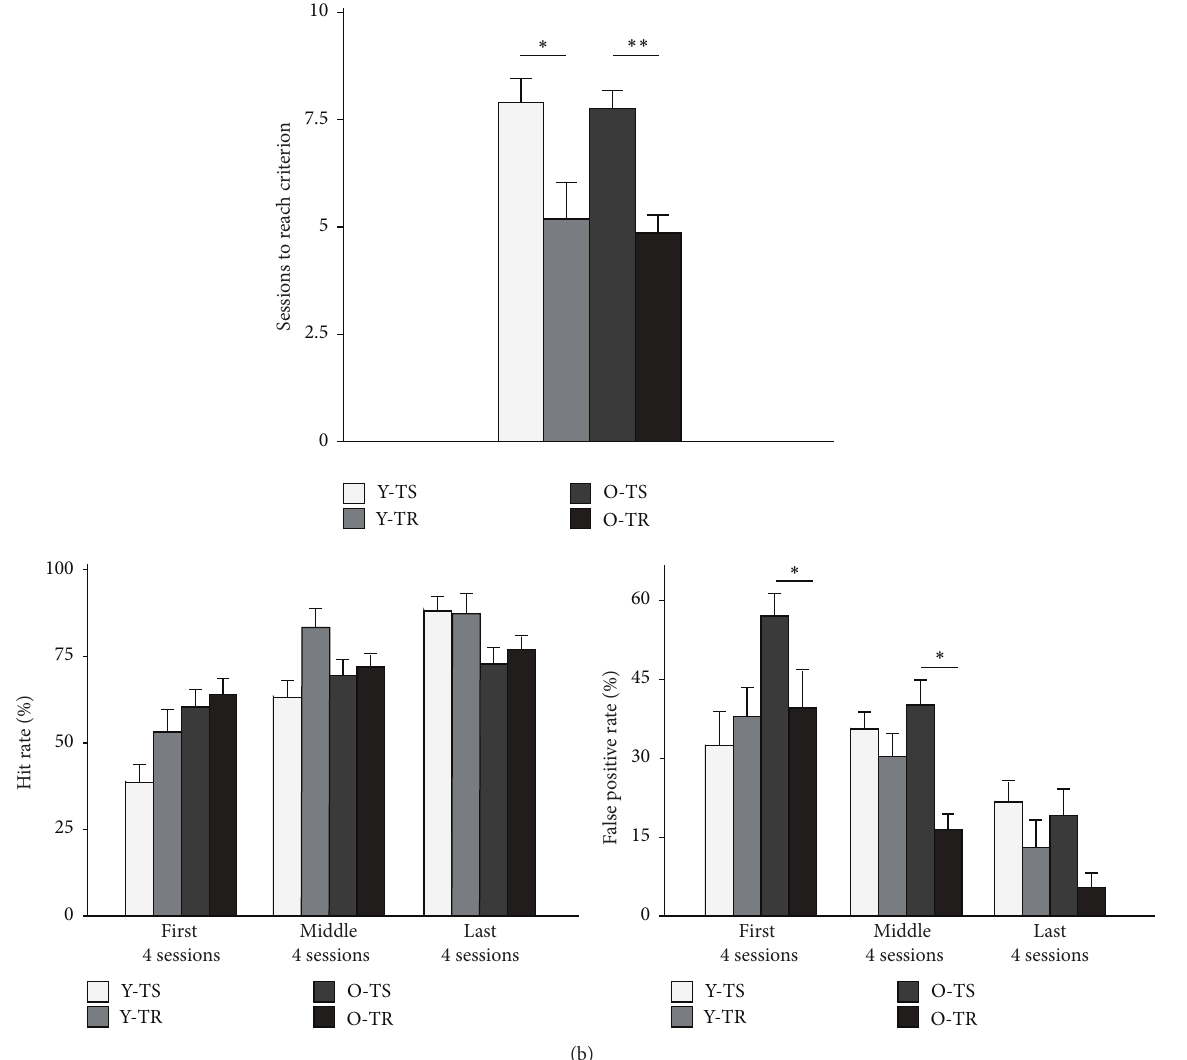
Figure 2: Impact of rivastigmine on auditory discrimination learning in young and older rats. Young (12–14 months old, 𝑛 = 11 ) and aging (24–30 months old, 𝑛 = 9 ) rats were trained on a two-tone discrimination task. In this go-no-go experimental paradigm, rats were rewarded with food for performing a behavioral response only when a 5 kHz tone was presented. The nontarget was always a 10kHz tone. Lack of response to a target (miss) or a response to a nontarget (false positive) resulted in a delay before the next trial. One group of younger (Y-TR, 𝑛 = 6 ) and older rats (O-TR, 𝑛 = 4 ) was administered rivastigmine orally prior to each training session. The other younger and older groups (Y-TS, 𝑛 = 5 , and O-TS, 𝑛 = 5 ) were administered an equivalent volume of saline before training. (a) Top row : average performance of younger and older rats on the training across time. A d -prime of 1 was used as the main criterion to determine mastery on the task. Middle row : average hit rate for each experimental group as a function of training sessions completed. Bottom row : average false positive rate for each experimental group as a function of training sessions completed. (b) Top row : average number of sessions to reach criterion in all experimental groups. Bottom rows : average hit rate and false positive rate, respectively, for the first and last four training sessions in all experimental groups. Values shown are mean ± SE. ∗ 𝑝 < 0.05 : ∗∗ 𝑝 < 0.001 : 𝑡 -test.